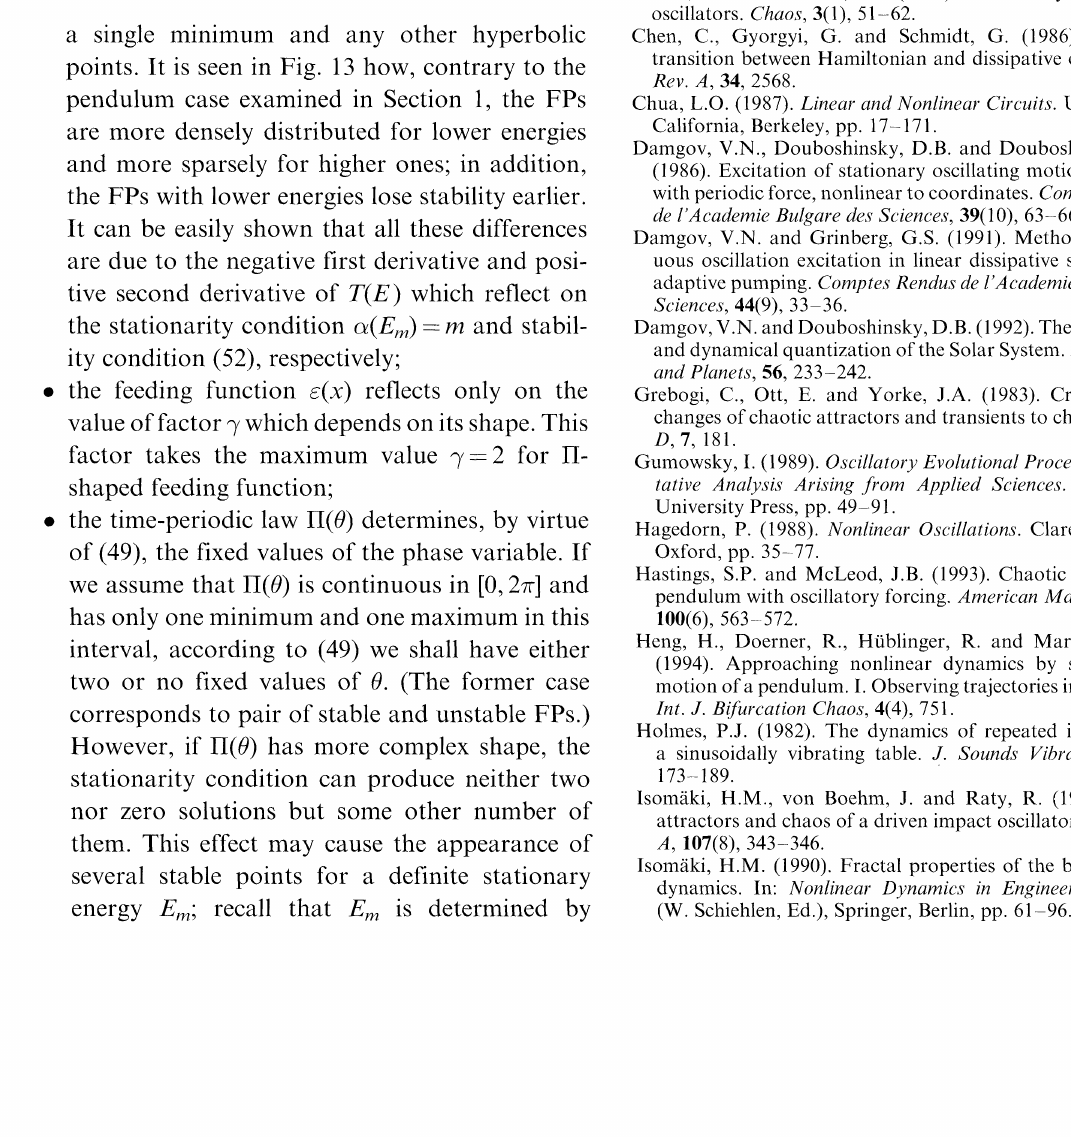
FIGURE 13 A multiple bifurcation diagram for kicked Duffing oscillator with single potential